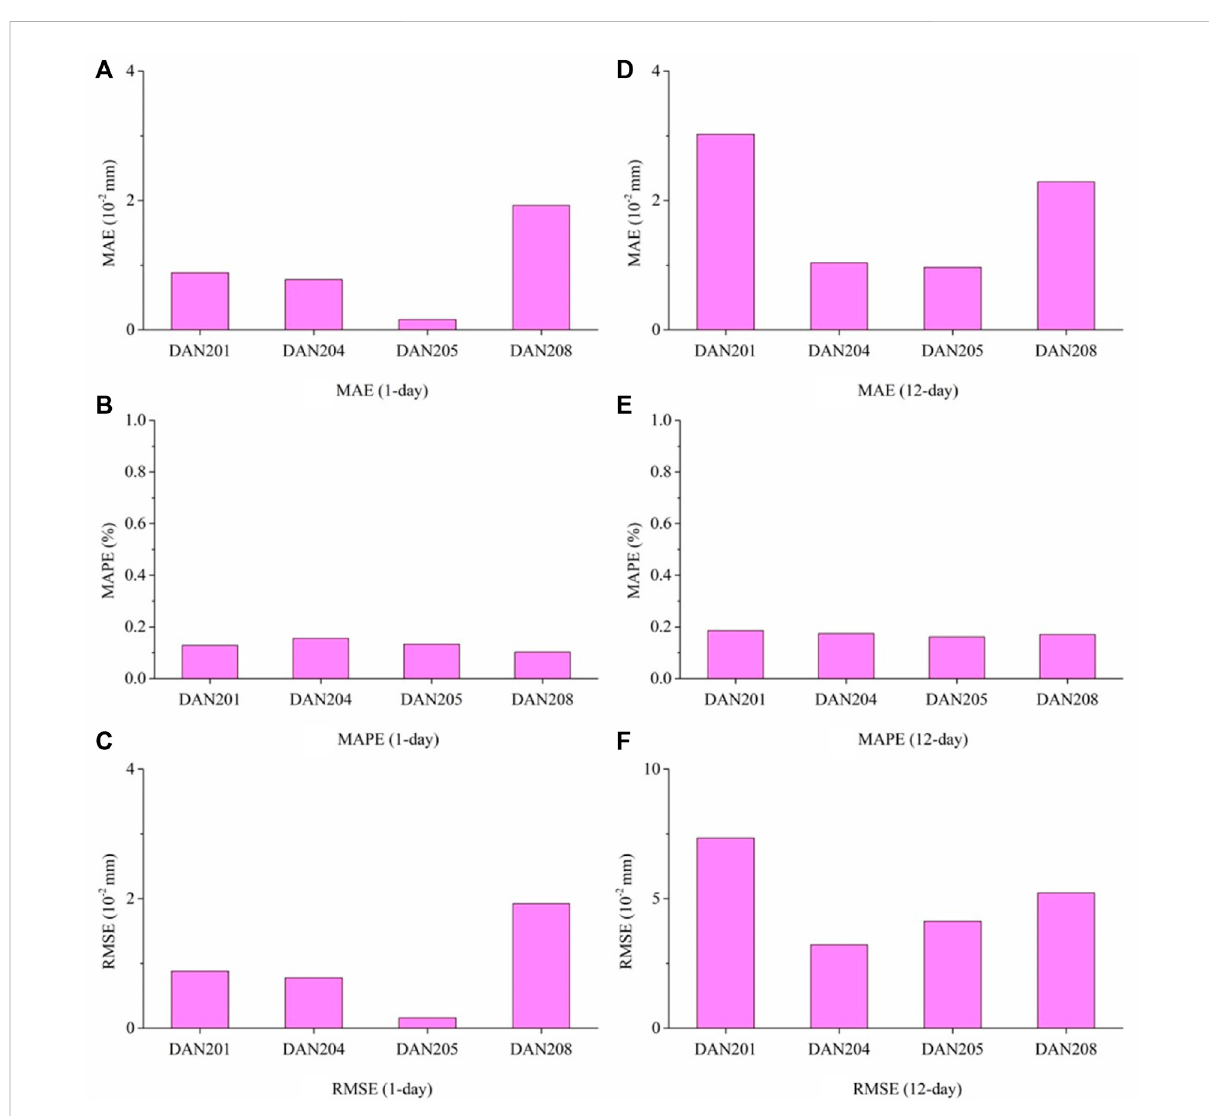
FIGURE 5 Summary of all evaluation metrics across the selected GNSS